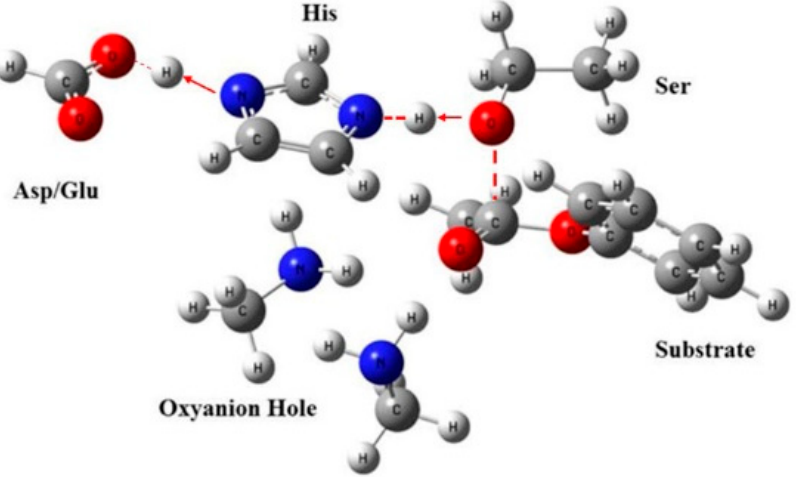
Figure 2. Optimized geometric model of the theozyme. The located transition structure of the theozyme residues is shown as a stick/ball model. Oxygen atoms are in red, nitrogen atoms are in blue, and carbon atoms are in grey.